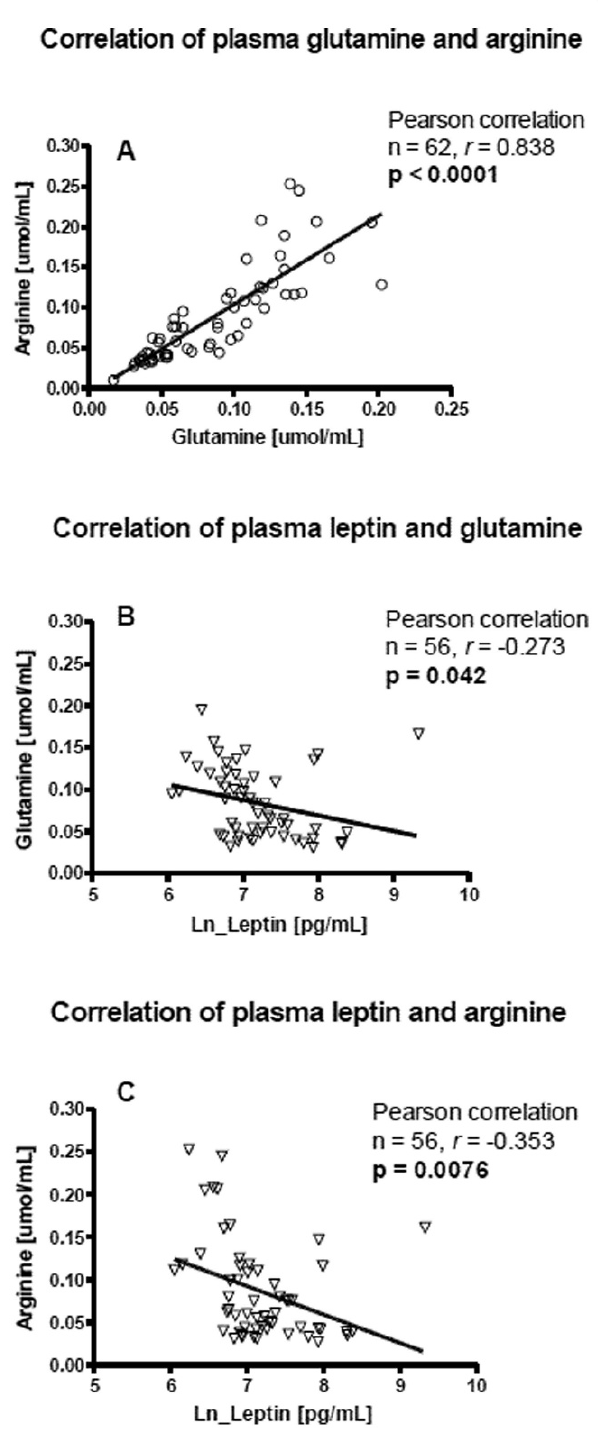
Figure 3 - Correlation at baseline between leptin, plasma glutamine and arginine concentrations on control, glutamine alone or all nutrients combined. A. Correlation of plasma glutamine with arginine concentration. B. Correlation of leptin with glutamine concentration. C. Correlation of leptin with arginine